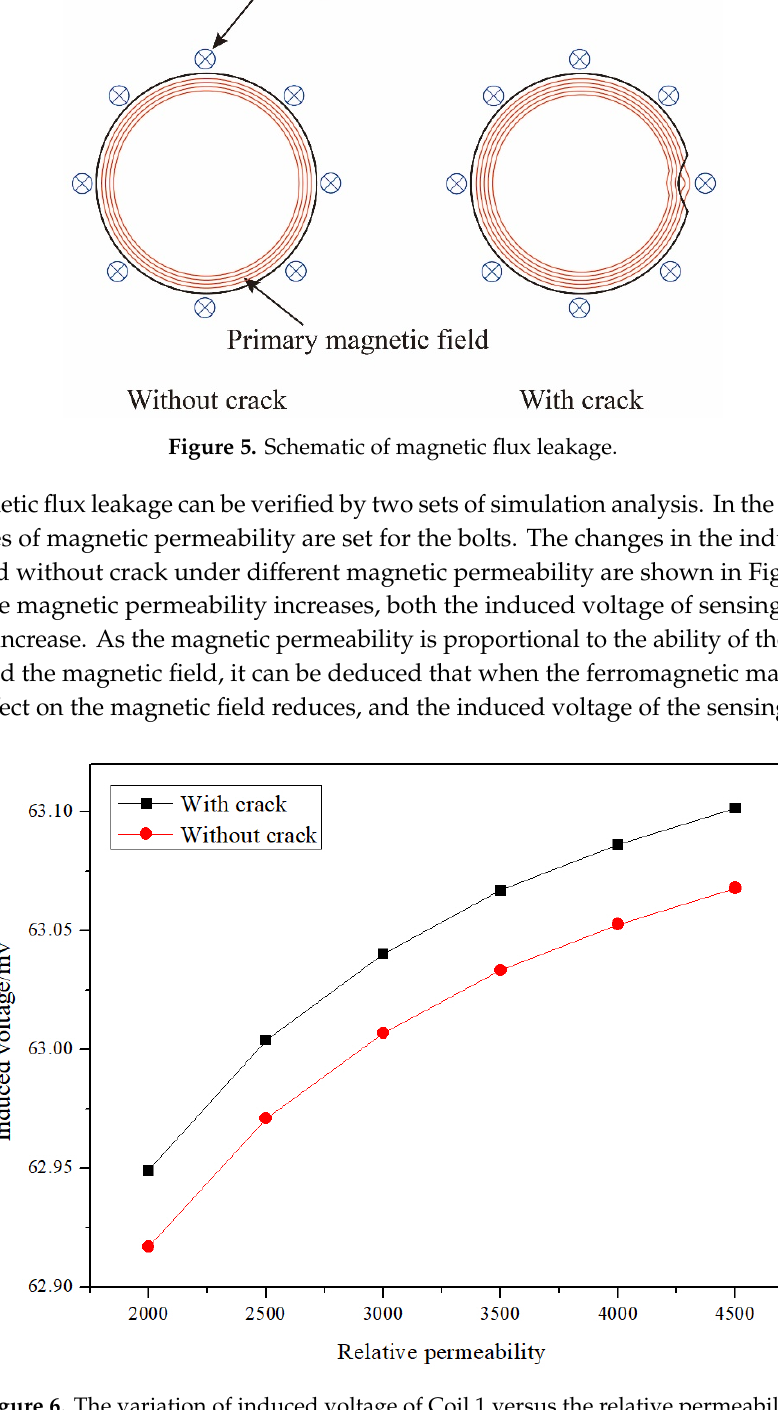
Figure 7. The variation of induced voltage of Coil 1 under different crack thicknesses. Based on the above analysis, the change in the induced voltage of Coil 1 in Figure 3 is divided into three stages: During Stage I, the crack initiates, and its depth is small, the influence of magnetic flux leakage is stronger than the eddy current effect, which causes a decrease of the induced voltage. In Stage II, the magnetic flux leakage is weakened as the crack propagates, and the eddy current effect is stronger than the magnetic flux leakage. It causes an increase in the induced voltage, but the voltage under this condition is still lower than that without crack. As the crack continues to propagate, it will progress to Stage III, where the induced voltage is large than that without crack and increases continuously as the crack propagates. Although the varying tendency of the induced voltage with the crack propagation is not monotonous, Stages I and II are short so that they can be both considered in the period of the crack